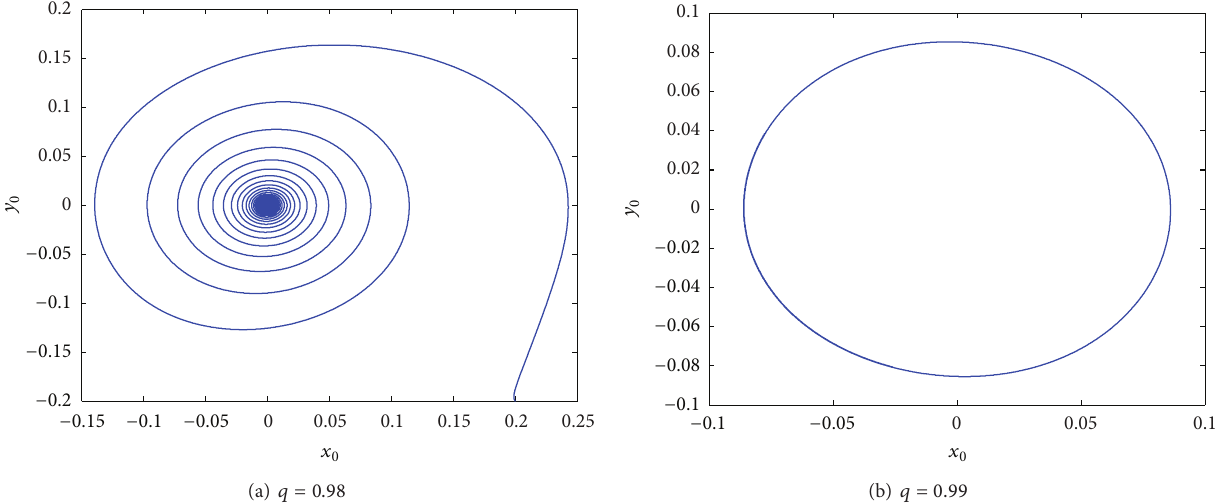
Figure 4: The phase diagrams for different values of order 𝑞 .